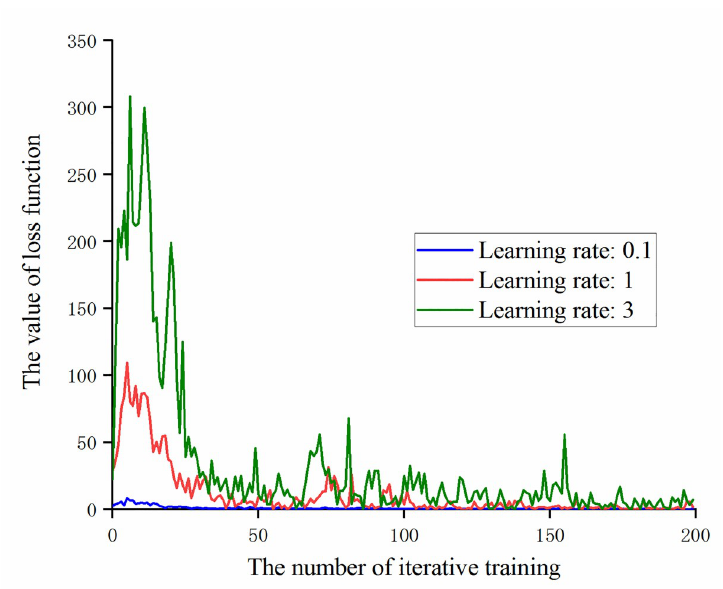
Fig 9. The trend of loss function value with the number of iterative training at large learning rates.